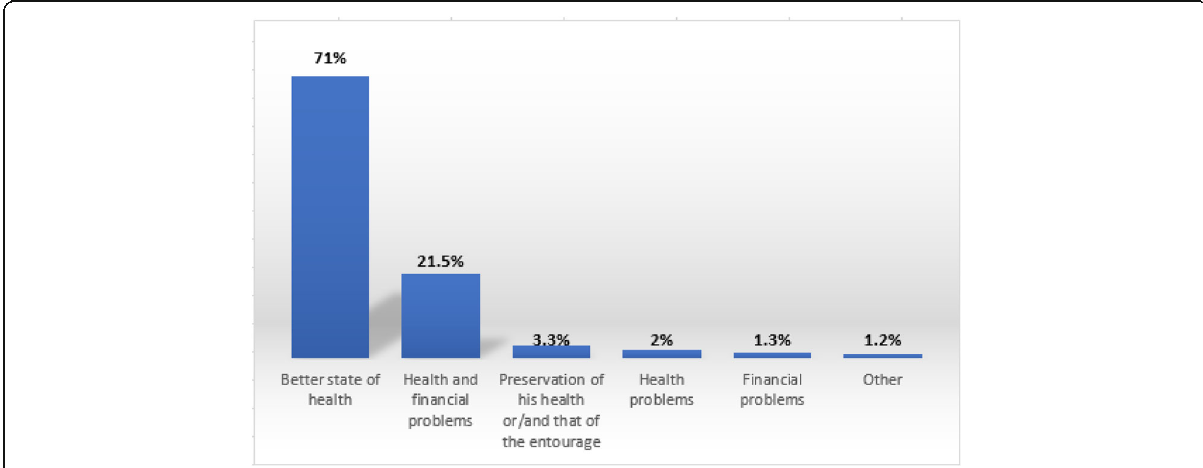
Fig. 2 Distribution of smokers according to the reasons for the decision to quit